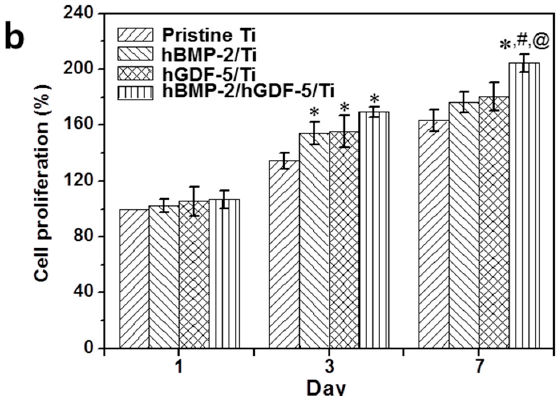
Figure 5. ( a ) Fluorescence microscope images (200×) and ( b ) in vitro cell proliferation rates of MC3T3-E1 cells cultured on pristine Ti, hBMP-2/Ti, hGDF-5/Ti, and hBMP-2/hGDF-5/Ti samples for 1, 3, and 7 days of culture, as compared to that of MC3T3-E1 cells cultured on culture plates (control). F-actin stain was carried out with phalloidin-Alexa Fluor 555. The error bars represent mean ± SD ( n = 3). These experiments were repeated three times (* p < 0.05, # p < 0.05, and @ p < 0.05). Controls of * the p -values were pristine Ti, hBMP-2/Ti, and hGDF-5/Ti, respectively.